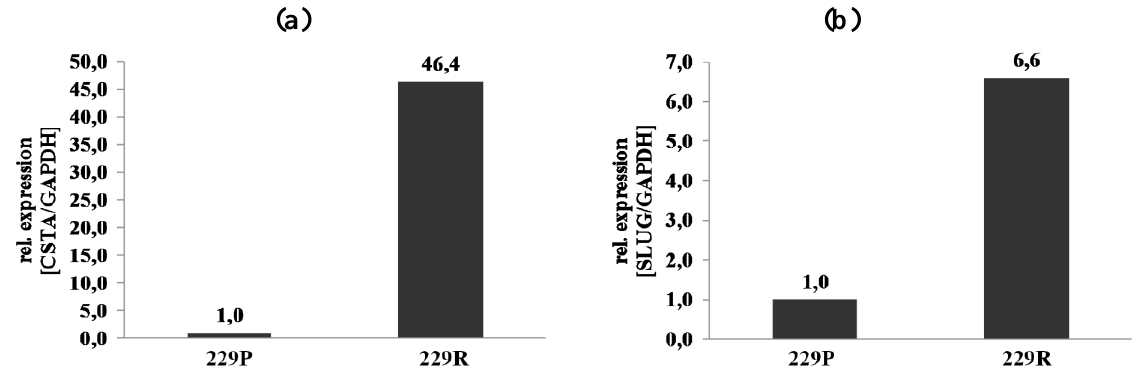
Figure 2. Validation of microarray data by quantitative reverse transcription-PCR (qRT-PCR). Relative expression levels of genes that were differentially expressed in Group 1: ( a ). CSTA, or Group 2; ( b ). Snai2/SLUG in 229P, and 229R cells of samples that were included in the whole-genome microarray expression